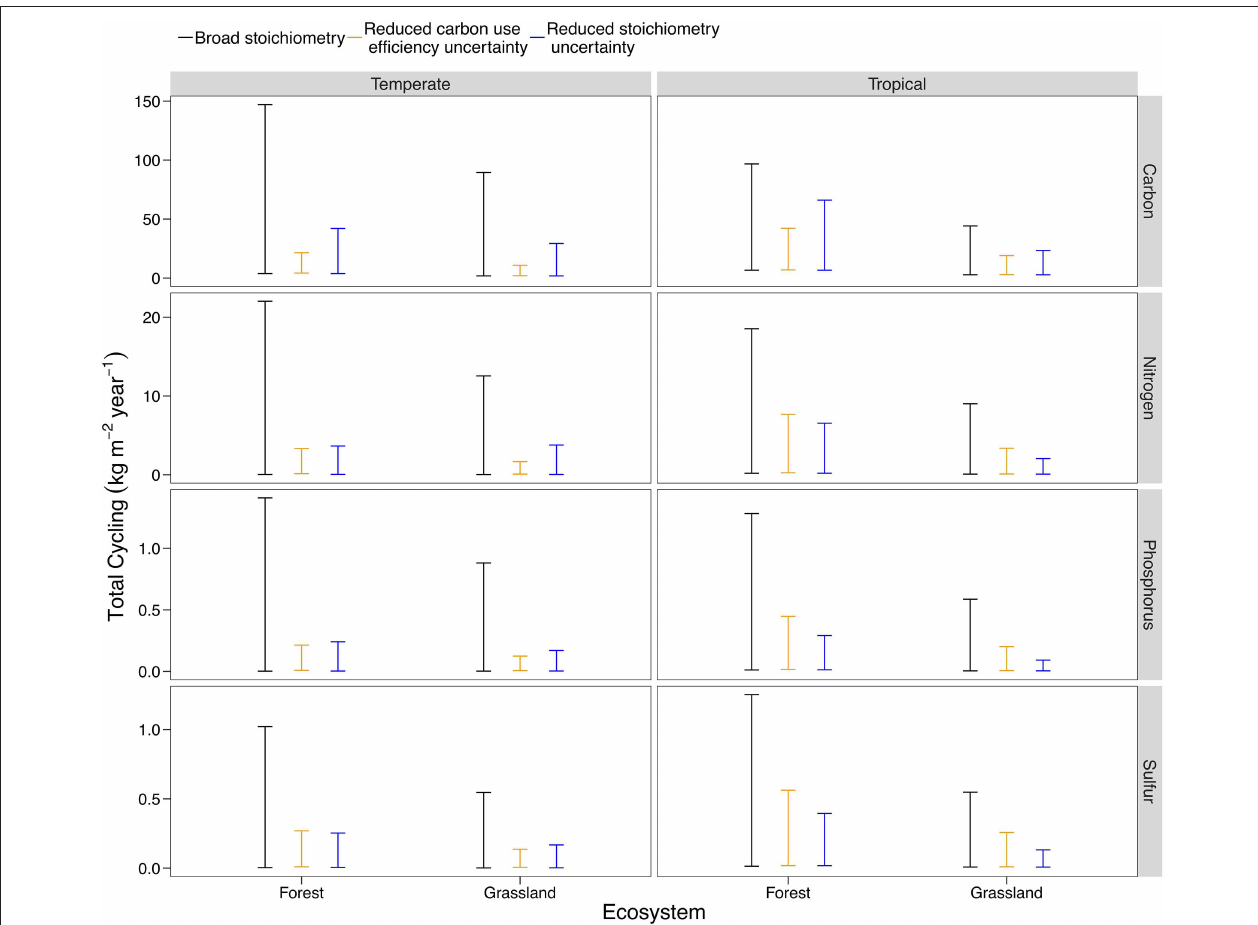
FIGURE 6 | A comparison of model behavior across ecosystem types, using temperate and tropical, forests, and grasslands as an example. The baseline uncertainty corresponds to the broad C:N:P:S scenario in earlier model results ( Figure 3 ), but is different across ecosystem types due to stricter constraints on the range of possible C:N:P:S ratios and CUE. The base scenario is compared with a 90% reduction in the uncertainty of stoichiometry (analogous to the minimum of the error bars in Figure 1 : Broad C:N:P:S) and a 90% reduction in the uncertainty of CUE. Plots for the 27 different ecosystem-biome combinations are presented Figure S5